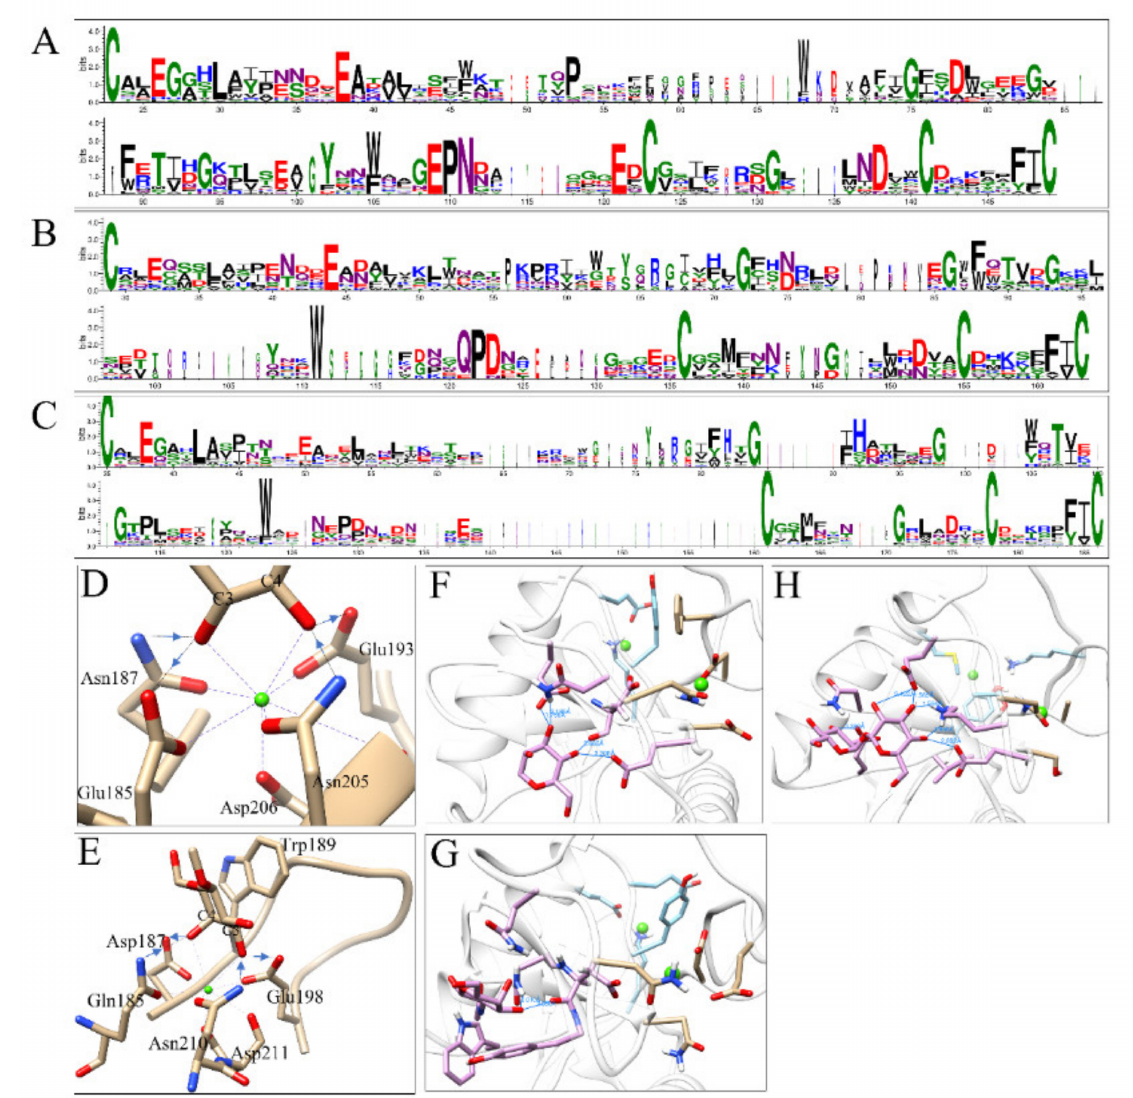
Figure 6. Sequence logos and structures of CRDs. Sequence logos of the ‘EPN-type’ ( A ); ‘QPD-type’ ( B ); and ‘noncanonical- type’ ( C ) CRDs were generated using WebLogo. Amino acids were colored according to chemical properties: polar, green; neutral, purple; basic, blue; acidic, red; hydrophobic, black. The sugar-binding sites of rat MBP-A (PDB: 2MSB) ( D ) and the MBP-A (QPDWG) mutant (PDB: 1AFA) ( E ). The coordination bonds and hydrogen bonds were shown as purple and black dashed lines, respectively. Ca 2+ ions were shown as green dots. Blue arrows indicate the direction of hydrogen bonds from the hydrogen donors to acceptors. The predicted structures of ‘EPN’ IML-10-CRD1 ( F ), ‘QPD’ IML-14-CRD1 ( G ), and ‘EPD’ IML-17-CRD1 ( H ). Hydrogen bonds were shown as blue lines with distance